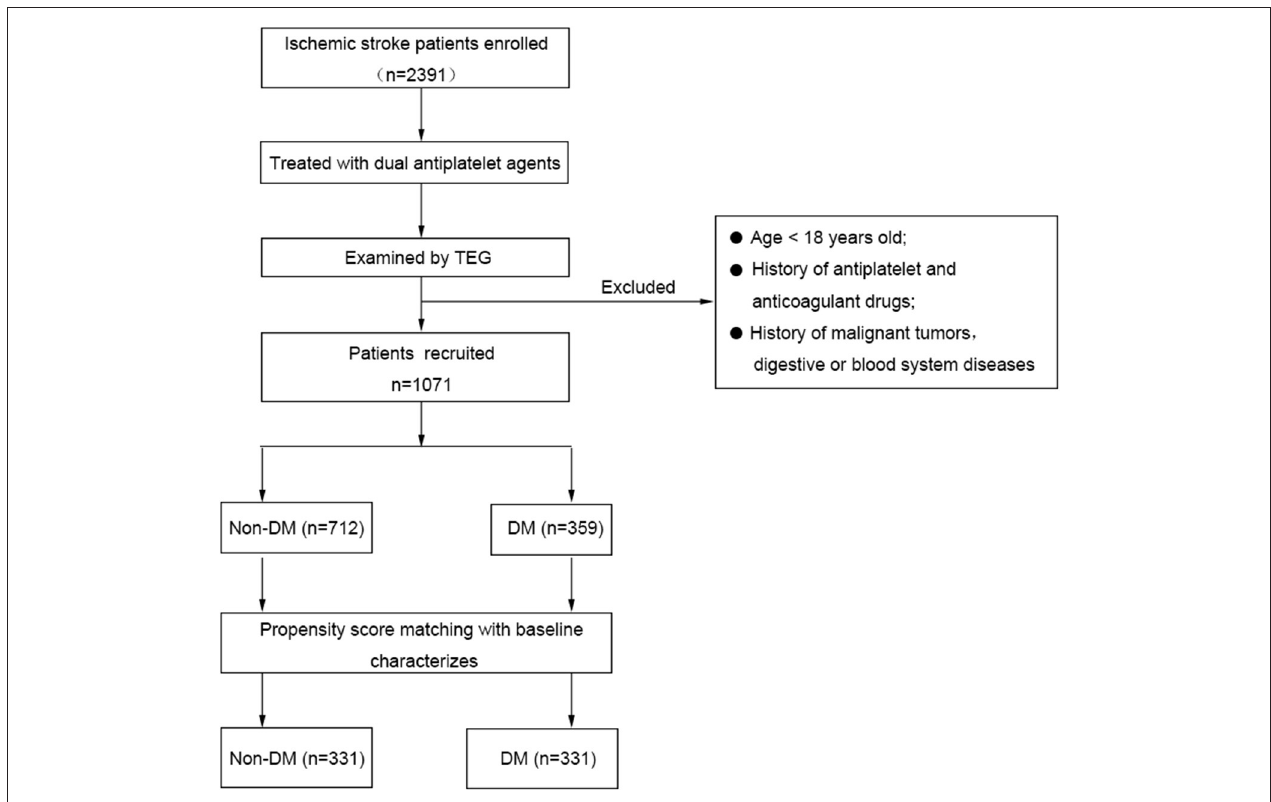
FIGURE 1 | Flowchart of patient